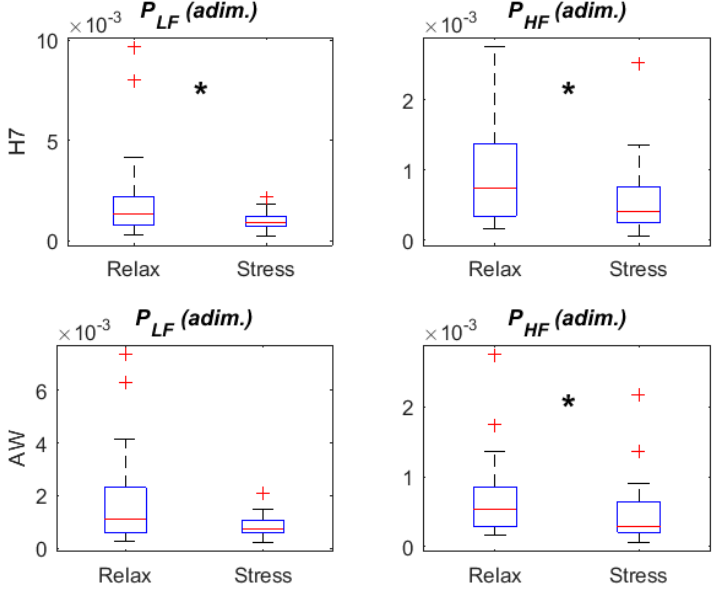
Figure 6. HRV parameters: frequency domain (Relax vs. Stress). * denotes significant differences ( p < 0.05) between adjacent boxplots. Adim refers to adimensional units.